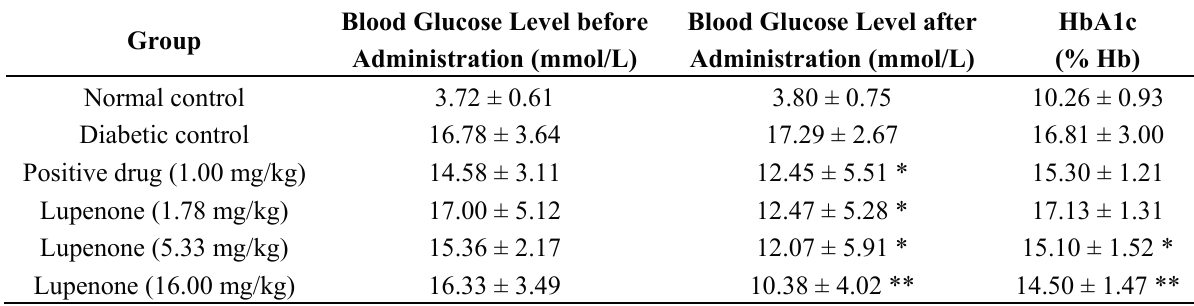
Table 8. Effects of Lupenone on FBG and HbA1c levels in rats.